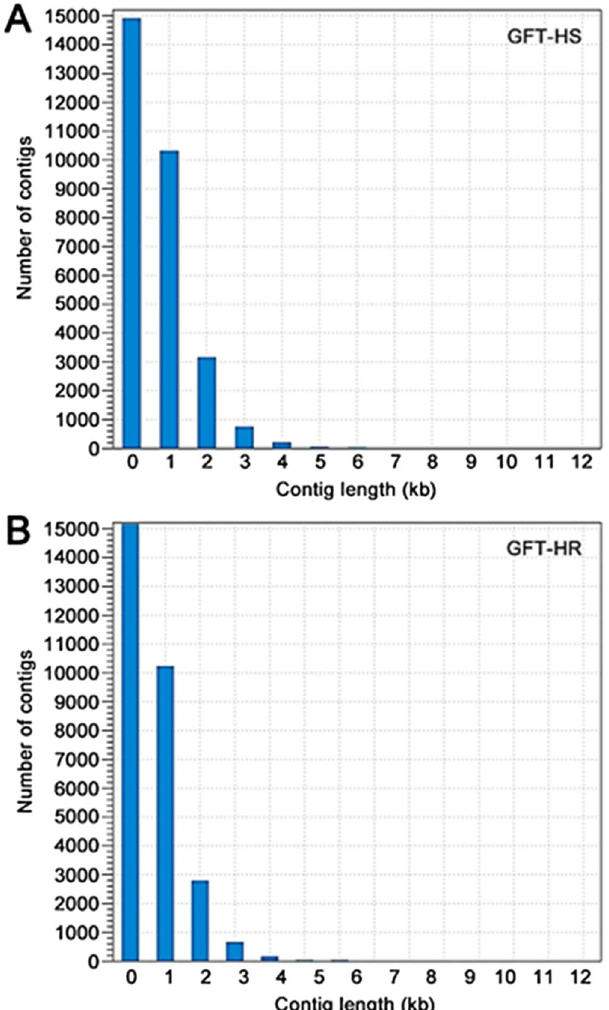
Figure 2. Length and taxonomy distribution of de novo assembled contigs for GFT-HS ( A ) and GFT-HR ( B